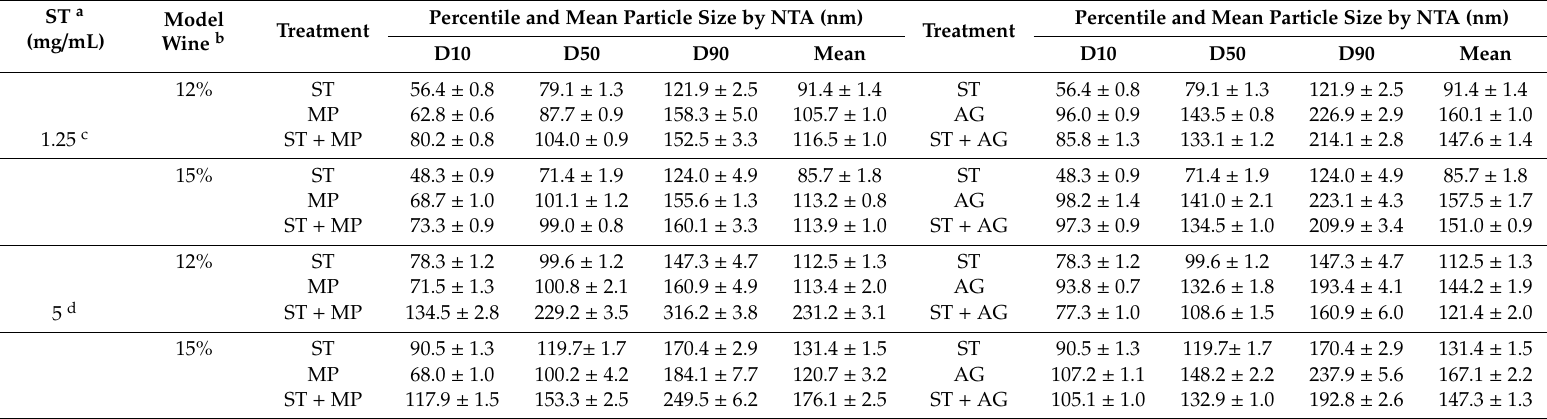
Table 2. Particle size of seed tannin (ST) combined with commercial mannoprotein (MP) or gum arabic (AG) at 0.5 mg / mL measured by nanoparticle tracking